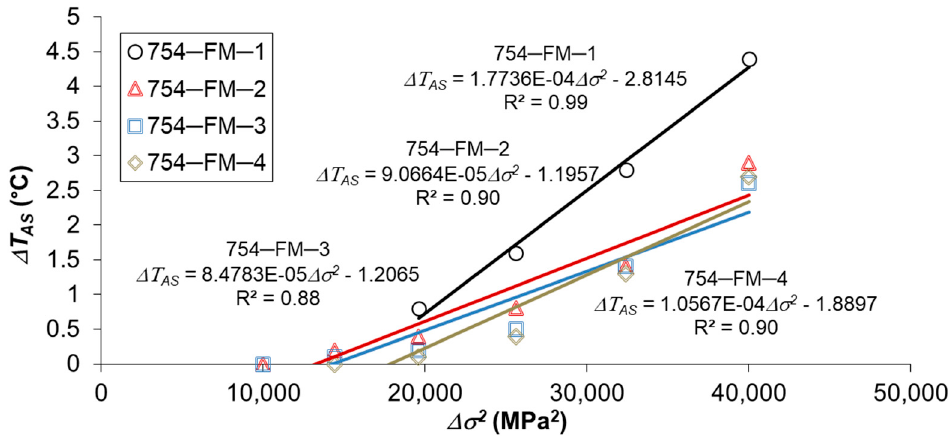
Figure 7. ∆ T AS – ∆ σ 2 curves for type-C-1 Figure 7. Δ T AS ─ Δ σ 2 curves for type-C-1 joints.